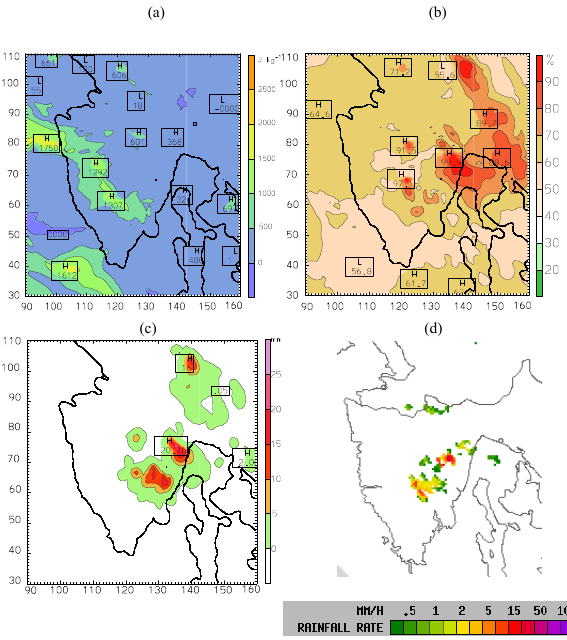
Figure 8. Horizontal distributions on 8 August 2006 of (a) the CAPE (J kg -1 ) at 12 CET that 8 Fig. 8. Horizontal distributions on 8 August 2006 of (a) the CAPE represents the potential for deep convection; (b) the averaged relative humidity (%) in the 9 (Jkg − 1 ) at 12:00CET that represents the potential for deep con- layer between 850 hPa and 500 hPa at 13 CET; (c) total precipitation (mm) from 13-14 CET 10 vection; (b) the averaged relative humidity (%) in the layer between total precipitation in past 1 h; (d) rainfall rate at 13:40 CET (source: ARSO-www.meteo.si). 11 850hPa and 500hPa at 13:00CET; (c) total precipitation (mm) from 12 13:00 to 14:00CET total precipitation in past 1h; (d) rainfall rate at 13:40CET (source: ARSO –